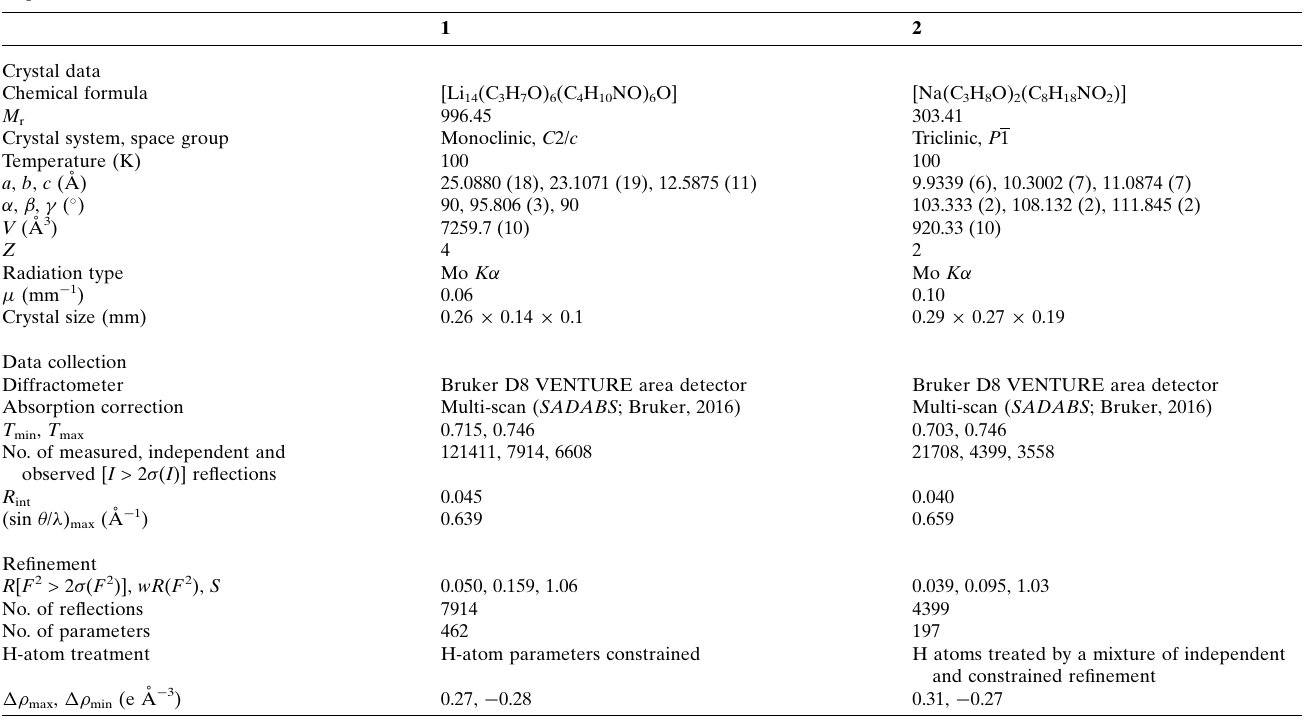
Table 4 Experimental details.